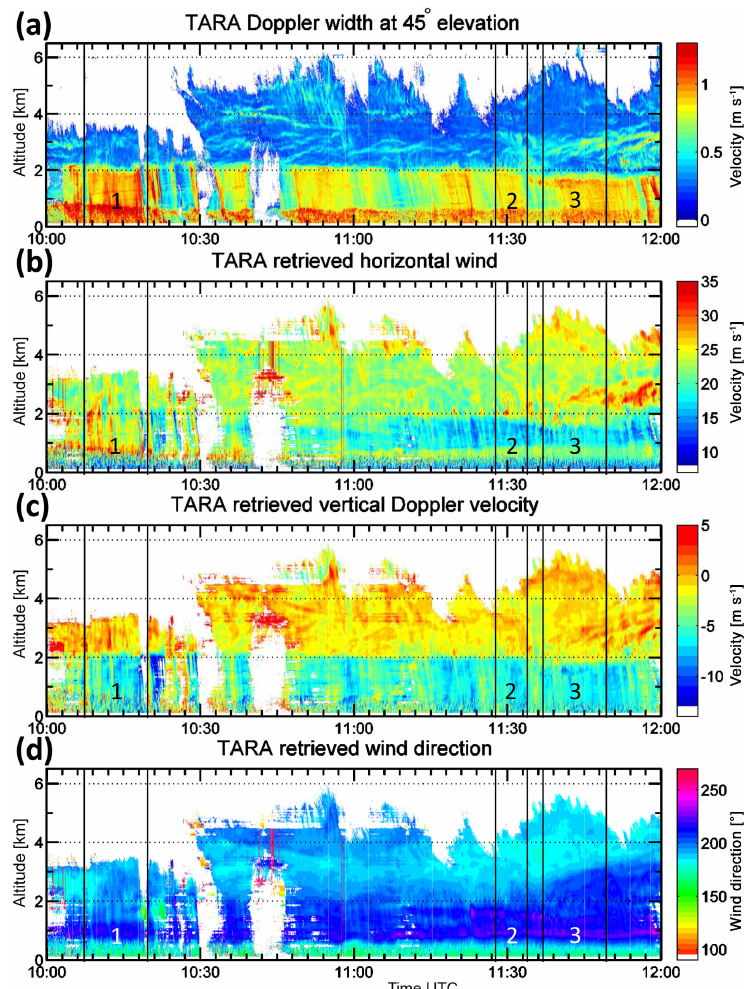
Figure 5. Overview of the dynamic variables measured and retrieved by TARA radar (S-band). In panel (a) the Doppler width is displayed, panel (b) shows the retrieved horizontal wind velocity, panel (c) the retrieved vertical Doppler velocity, and panel (d) the retrieved wind direction. The boxes 1, 2, and 3 highlight the time frames where fall streaks at 10:12:50, 11:33:31, and 11:47:30UTC are retrieved, and their rearranged data are discussed and